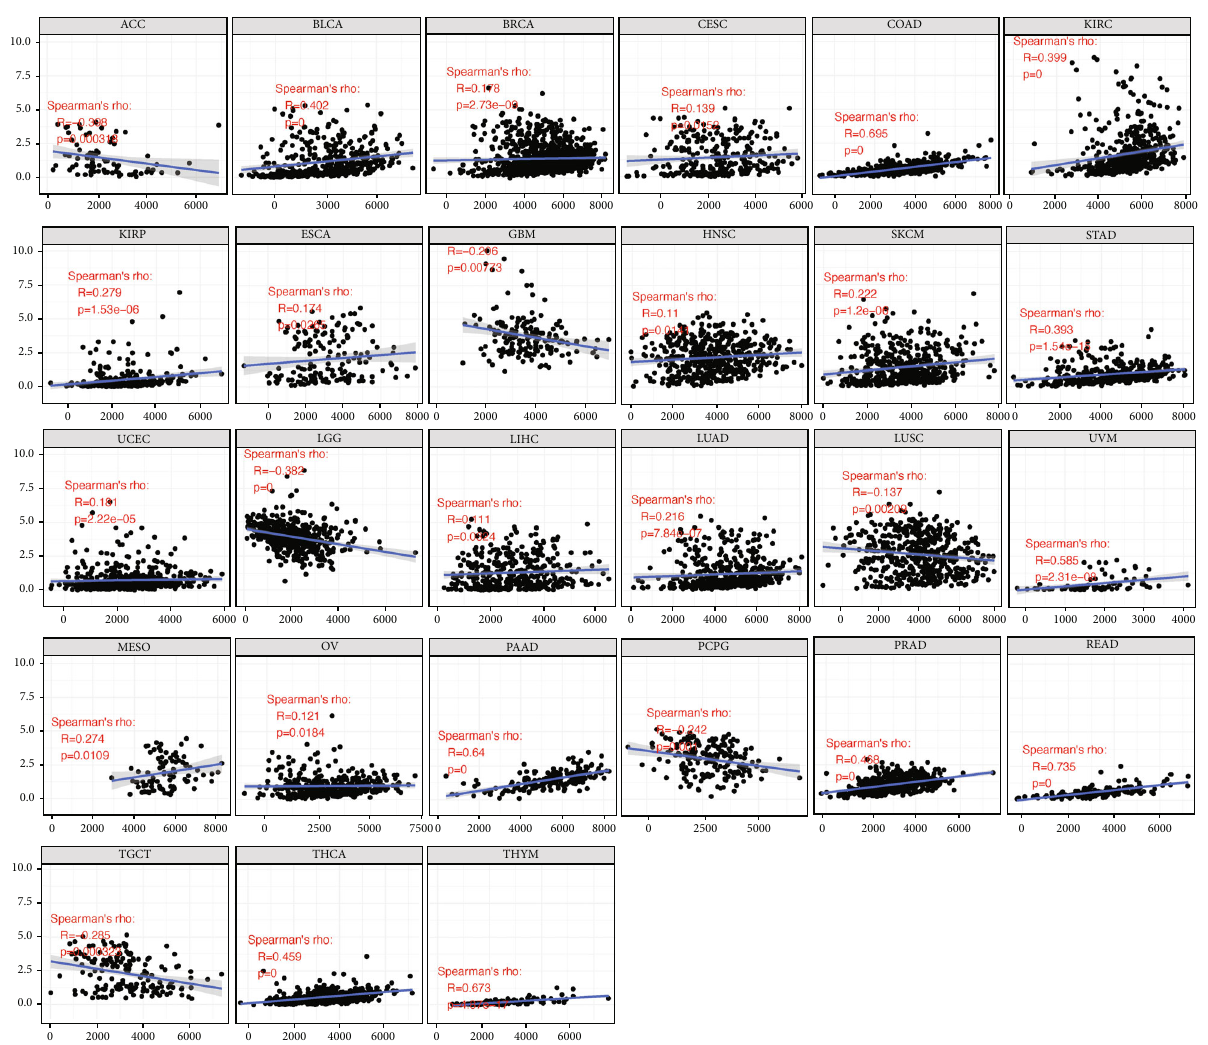
Figure 7: Correlation of B4GALNT1 expression with StromalScore in ACC, BLCA, BRCA, CESC, COAD, KIRC, KIRP, ESCA, GBM, HNSC, SKCM, STAD, UCEC, LGG, LIHC, LUAD, LUSC, UVM, MESO, OV, PAAD, PCPG, PRAD, READ, TGCT, THCA, and